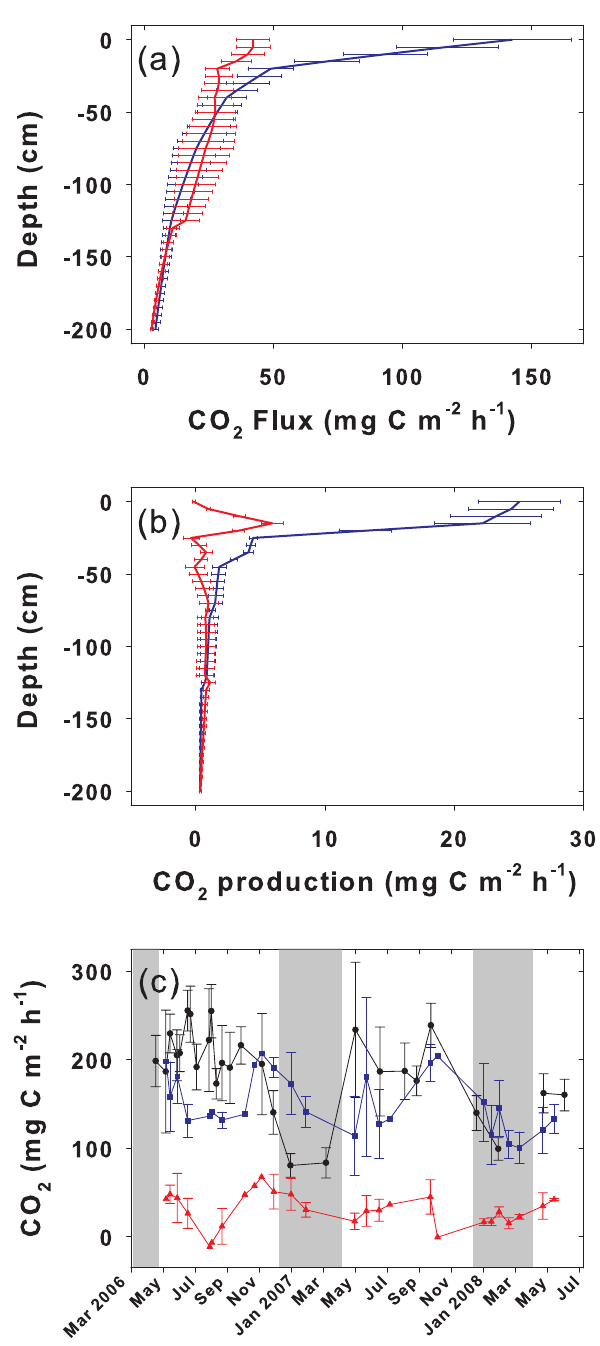
Figure 4. Mean (± SE, n = 3) modeled soil CO 2 a) fluxes and b) production rates with soil depth as well as c) time series of measured ( ─, •) and modeled soil CO 2 efflux. CO 2 fluxes and production were calculated with the soil-CO 2 profile method, using the physically 850 modeled diffusion coefficients D (black line in Fig. 3a and b) with a sigmoidal ( ─, ▲ ) or exponential ( ─, ■ ) function to interpolate between the measured CO 2 concentrations. Grey shadings in c) mark the dry seasons.